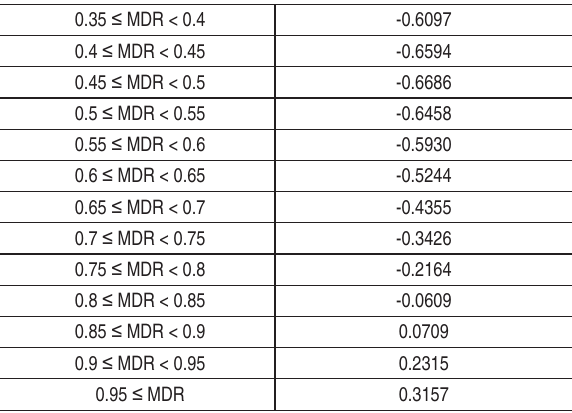
Table 3 (cont.). SFE model for marginal effect estimation